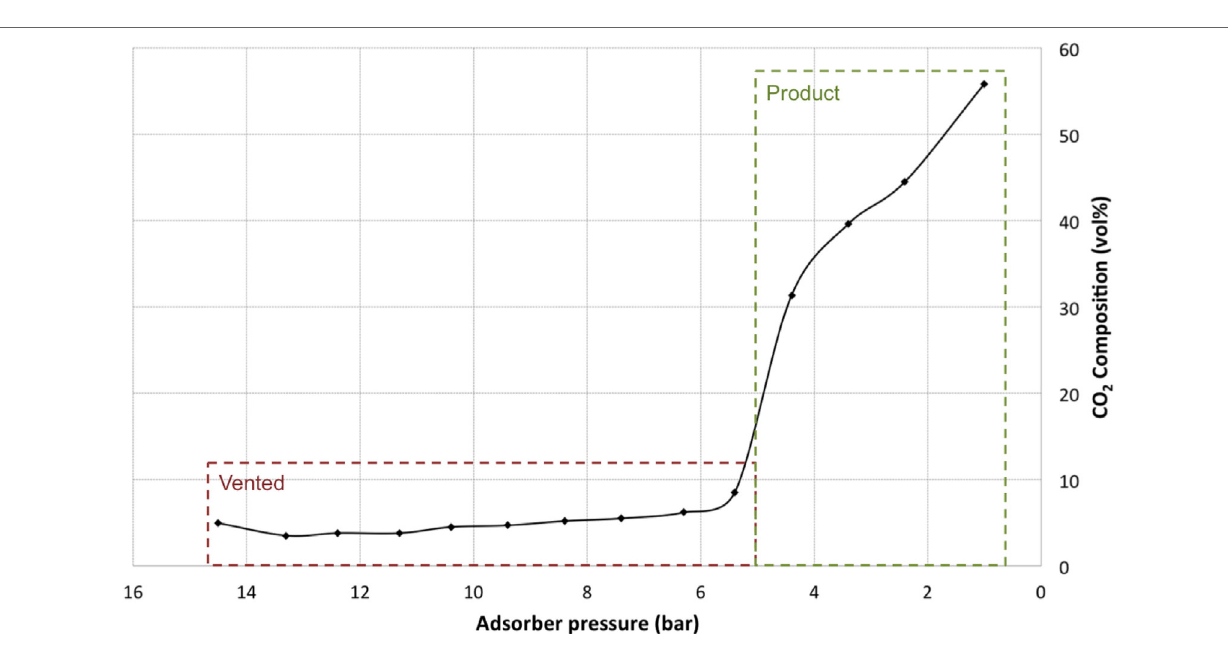
FigUre 10 | CO 2 composition at the adsorber outlet with a gradual gas desorb of 50 mL/min with pressure dropping from 15 to 1 bar with an initial starting CO 2 concentration of 12.5%.